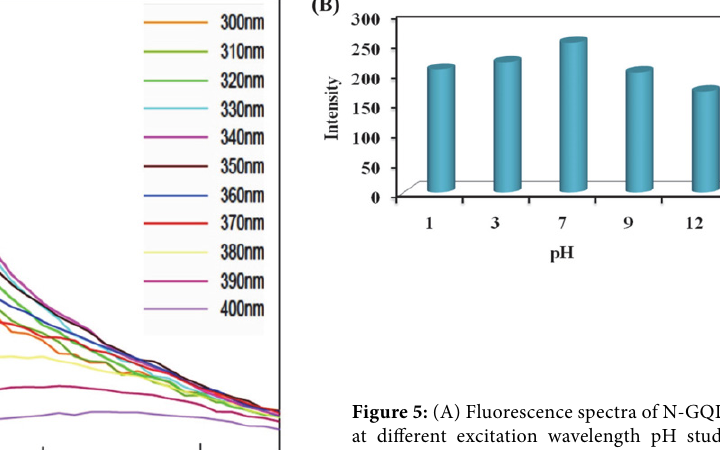
Figure 5: (A) Fluorescence spectra of N-GQDs at different excitation wavelength pH study; (B) Fluorescence intensity of N-GQDs at dif- ferent